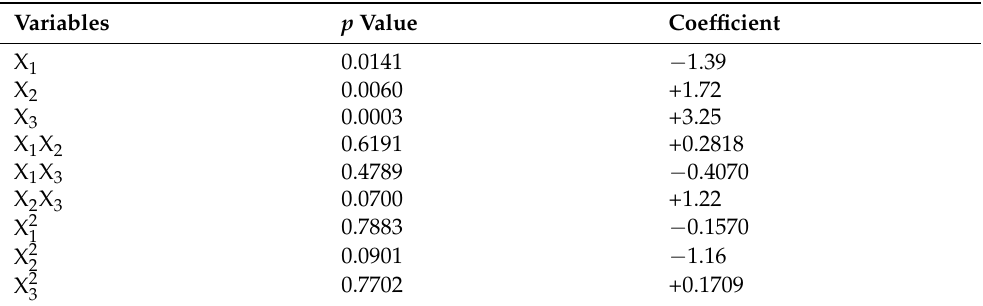
Table 4. Effects of the independent variables on the dependent variables and their statistical signifi- cance with respect to the extraction of anthocyanins from